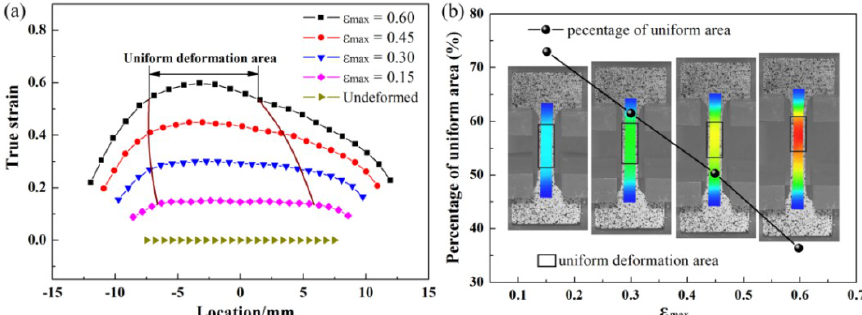
Figure 4. Non-uniform deformation behavior in the reduced section at 90 mm/min crosshead speed: ( a ) strain distribution at different stages; ( b ) percentage of uniform deformation area.